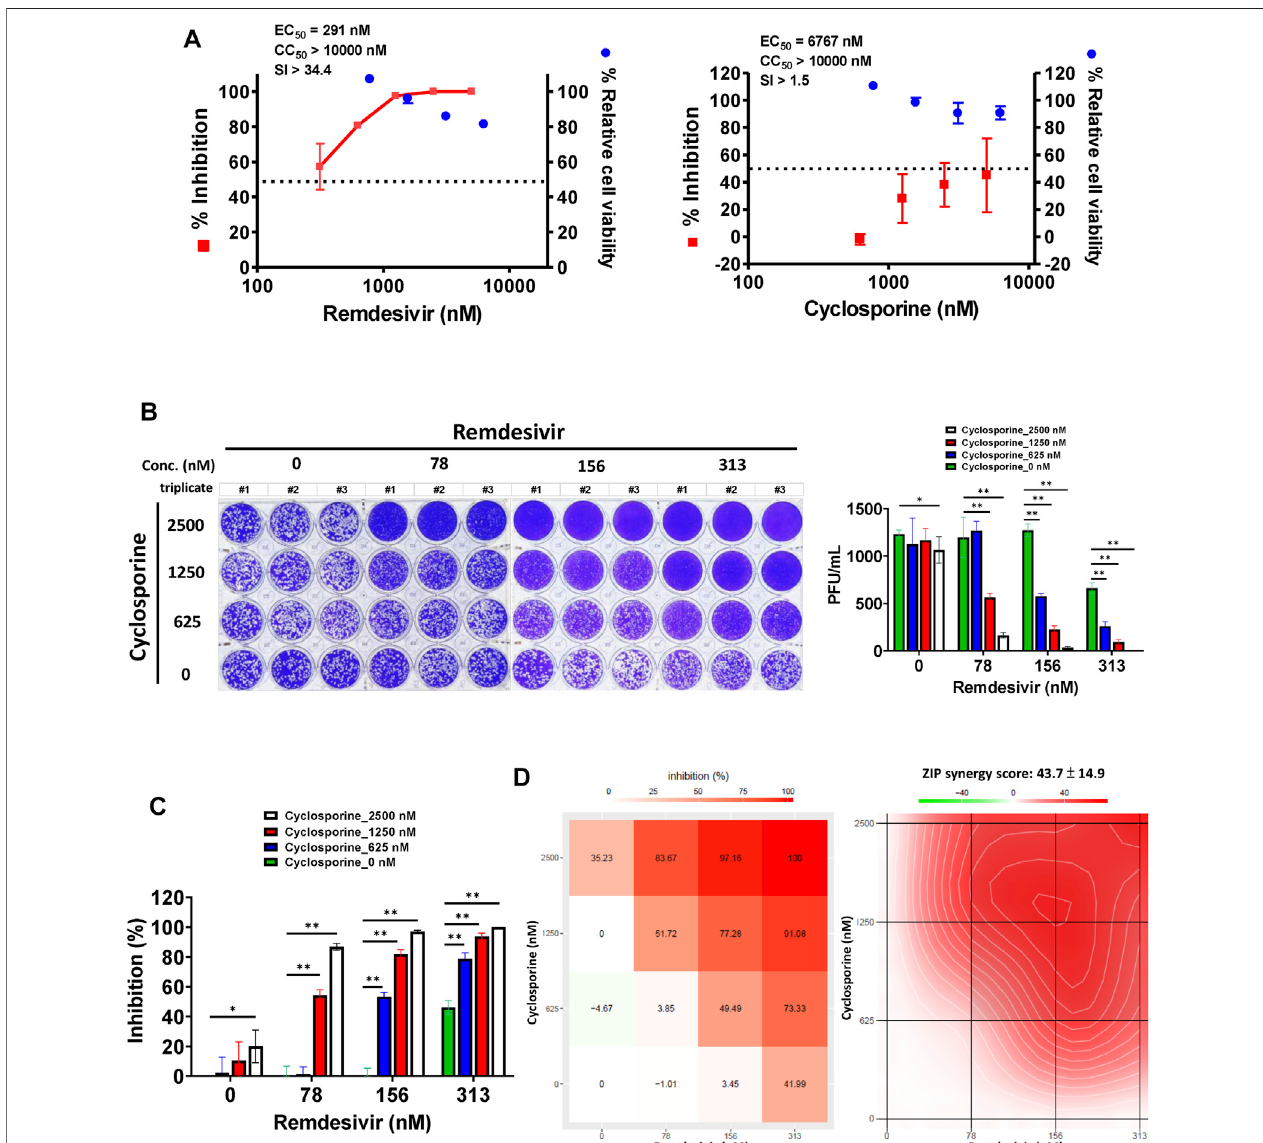
FIGURE 5 | Single or combined treatment with remdesivir and cyclosporine synergistically reduced infectious SARS-CoV-2 viral loads as determined by plaque formation assays. (A) Single treatment of SARS-CoV-2-infected Vero E6 cells with remdesivir and cyclosporine reduced the number of plaque-forming units in a dose dependent manner. (B) Combined treatment of SARS-CoV-2-infected Vero E6 cells with remdesivir and cyclosporine signi fi cantly decreased plaque formation caused by SARS-CoV-2. (C and D) Combined treatment of SARS-CoV-2-infected Vero E6 cells with remdesivir and cyclosporine synergistically reduced SARS-CoV-2 viralloads.Plaqueassayswereperformedintriplicateusing24-welltissuecultureplates.VeroE6cellswereseededinDMEMwith10%FBSandantibiotics1 daybefore infection.SARS-CoV-2wasaddedtothecellmonolayerfor1 hat37 ° C.Subsequently,viruseswereremovedandthecellmonolayerwaswashedoncewithPBSbefore covering with overlay media containing 1% methylcellulose (Sigma, cat#M0387) and the test compounds at indicated concentrations for 5 – 7 days. The cells were fi xed with10%formaldehydesolution(Marcon TM Chemicals,cat#H121-08)overnight.Afterremovalofoverlaymedia,thecellswerestainedwithcrystalvioletandtheplaques were counted. The percentage of inhibition was calculated as [1 – (VD/VC)] × 100%, where VD and VC refer to the virus titer in the presence and absence of the test compound, respectively. The inhibition in plaque formation results shown are representative of three independent experiments, each in triplicate (B) . Cell viability was determined as described (Kuo et al., 2021) by measurement of relative alkaline phosphatase activity; viability in the absence of compound treatment was set as 100%. AVE ± SD of three independent experiments were shown (A and C) ; The statistical signi fi cance was evaluated using one-way ANOVA followed by Tukey ’ s multiple comparisontest.*and**wereusedtodenotethestatisticalsigni fi cancefor p < 0.05,and p < 0.01respectively (C) .Showninhibition%(AVE)andsynergyscores(AVE ± SD) are from three independent experiments (D) analyzed via SynergyFinder (https://synergy fi nder. fi mm. fi /).